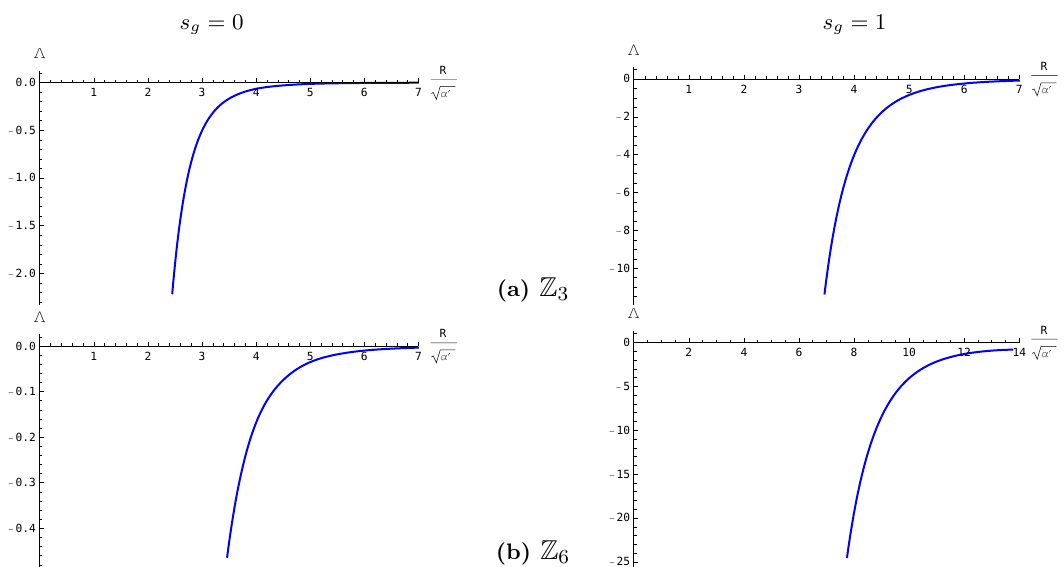
Figure 3. 1-loop Λ for N = 3 , 6 , class I ( T 2 × S 1 ) / Z N models with spin structures s g = 0 and s g = 1 . The vertical and horizontal axis correspond respectively to Λ and the circle radius in units √ of α 0 .